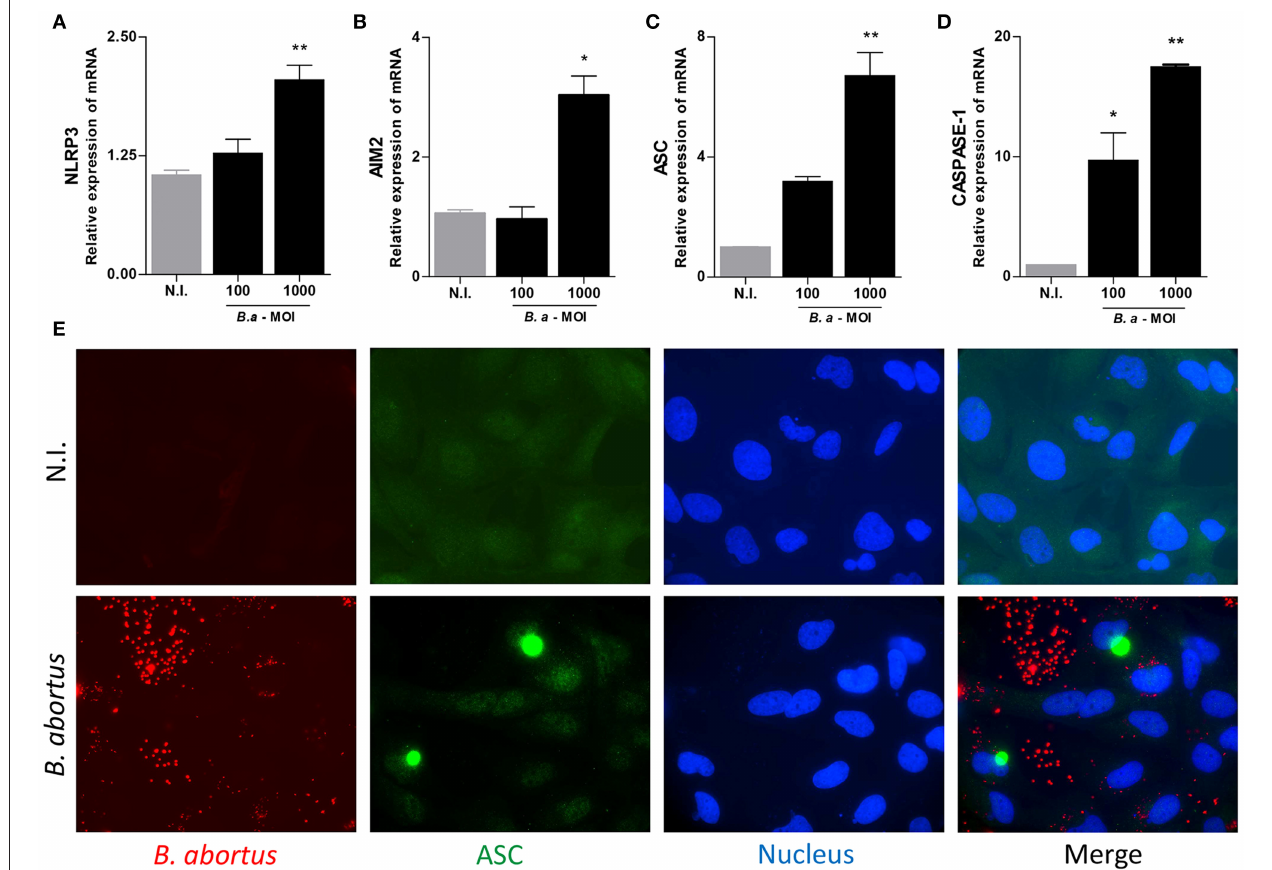
FIGURE 2 | B. abortus induces inflammasome in LX-2 cells. LX-2 cells were infected with B. abortus at MOI of 100 and 1000; at 24h, post-infection levels of NLRP3 (A) , AIM2 (B) , ASC (C) , Caspase 1 (D) , and IL-1 β (E) were determined by RT-qPCR. LX-2 cells were infected with Ds-Red B. abortus and ASC speck were revealed by immunofluorescence with a specific antibody labeled with Alexa 488. Nuclei were stained with DAPI. Data are given as the means ± SD from at least three individual experiments. * P < 0.05; ** P < 0.01 vs. non-infected cells (N.I.).